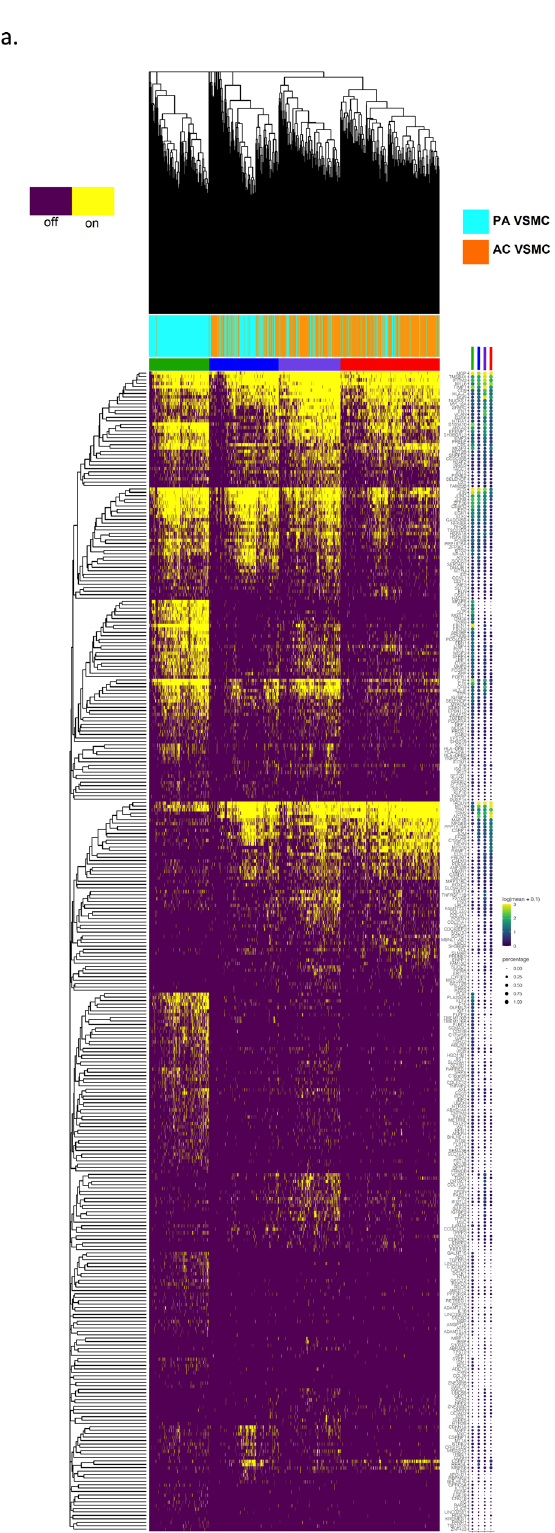
Fig. 4 Evaluation of VSMC and EC subpopulations. a , d Biclustered heatmap visualization of all signi fi cant genes ( q < 0.05) from VSMC ( a ) and EC ( d ) modules enriched with differentially expressed genes. a 1224 VSMCs from each anatomic location (2448 cells total). Large color bar denotes PA (cyan) and AC (orange) VSMCs. Small color bar above denotes distinct cell subpopulations (blue, forest green, lime green, brown, purple, magenta, red). d 448 ECs from each anatomic location (896 cells total) in. Large color bar denotes PA (blue) and AC (red) ECs. Small color bar above denotes distinct cell subpopulations (cyan, green, magenta). A dotplot corresponding to gene expression levels for each cell subpopulation on the heatmap is included. Colored dots next to speci fi c genes correspond to critical genes related to the designated cell subpopulation. Continuous gene expression based gene ontology enrichment analysis of biological function performed based on the fraction of AC cells per subpopulation of VSMCs ( b , c ) and ECs ( e , f ). n = 3 for PA and AC